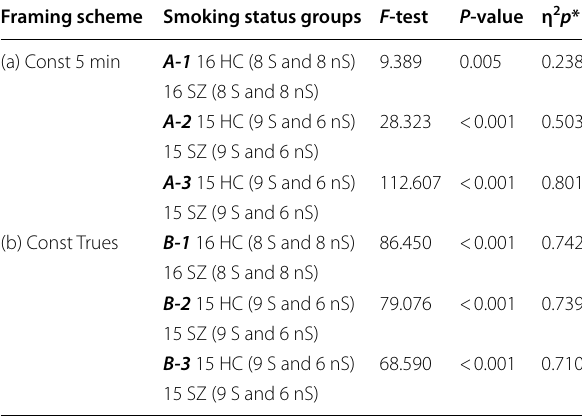
Table 1 Summary of all tested cases and correspondent results for smoking effects on BP ND Framing scheme Smoking status groups F